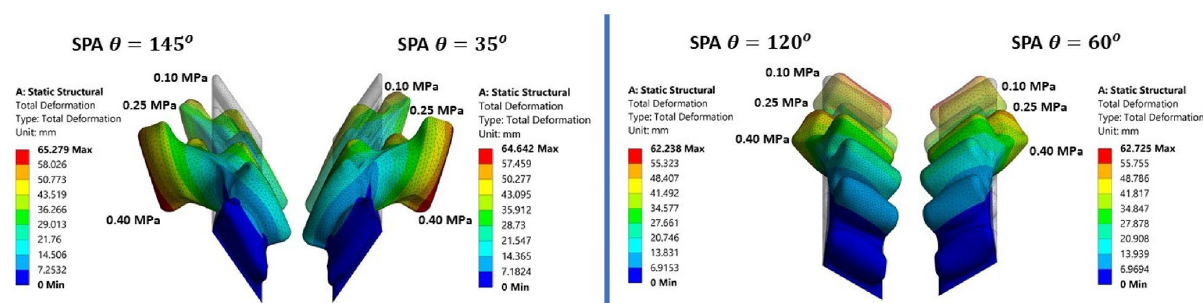
Figure 2. FEA results of accumulated deformation images on top of each other to show the effect of applied pressure on variable θ , SPA60, SPA120, SPA35, and SPA145 work envelope. FEA simulated work envelope for variable θ